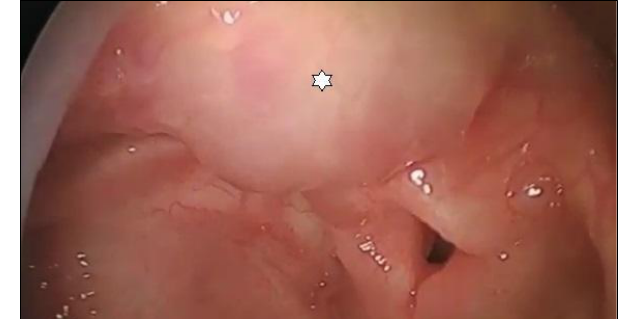
Figure 2: Fiber optic laryngoscopy view of the cystic lesion at vallecula (star).